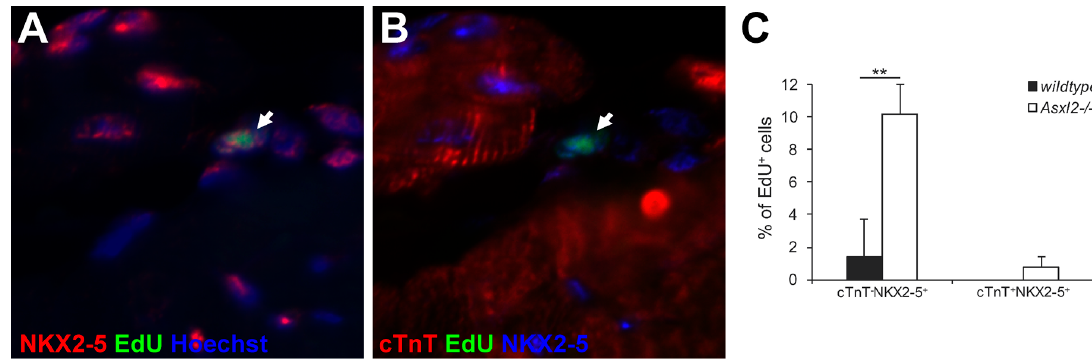
Figure 4. EdU + cells in 12-week Asxl2 − / − hearts show signs of being cardiogenic. ( A , B ) Paraffin heart sections from EdU-treated 12-week wildtype and Asxl2 − / − animals were labeled for EdU, NKX2-5, and cTnT; ( C ) Quantification of the percentage of EdU-labeled cells that were EdU + NKX2-5 + cTnT − and EdU + NKX2-5 + cTnT + . Sample size: n = 3 animals per genotype; three non-consecutive sections/heart; analyzed fifteen 20× left ventricle images/section; 177 wildtype EdU + cells, 252 Asxl2 − / − EdU + cells. Bars represent standard deviation. ** p- Value (Student’s t -test) < 0.01.